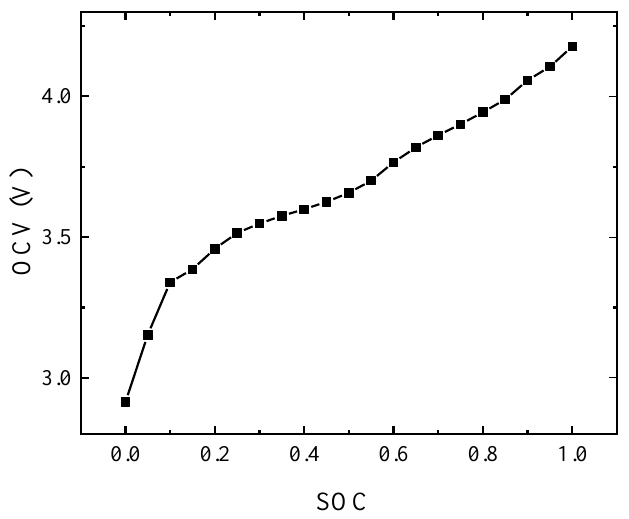
Figure 4. OCV values correspond to different SOC.